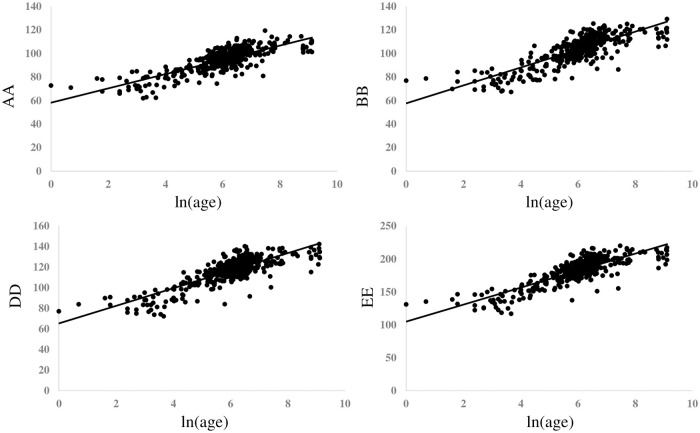
Width of the brain of those in normal control plotted in relation to ln(age), revealing that AA, BB, DD and EE were linearly correlated with ln(age), respectively. Results of regression analysis and Spearman’s rank correlation analysis is shown in separate table. AA, BB and DD: corresponding brain width to maximum distance between anterior horn, minimum bicaudate nuclei distance, third ventricle distance, respectively, EE: a square root of summation for AA2, BB2, and DD2, ρ; Spearman’s rank correlation coefficient.